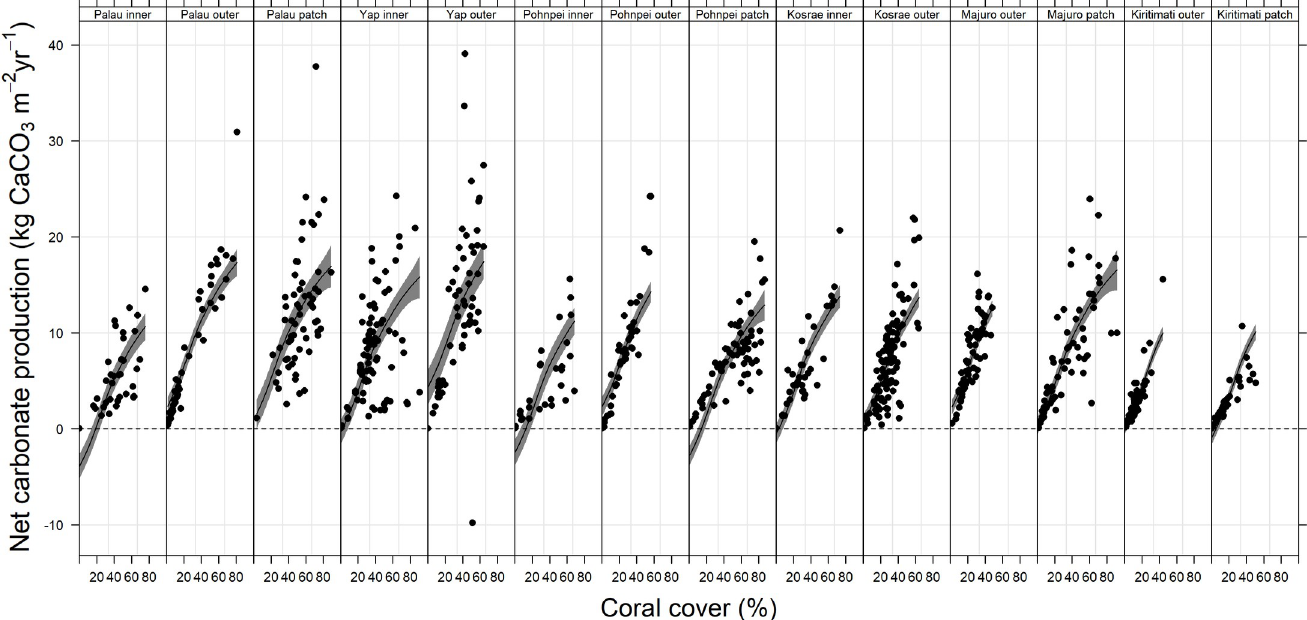
Fig 5. The relationship between the percentage (%) live coral cover and the net carbonate production rates (kg CaCO 3 m -2 yr -1 ) for each habitat (i.e., inner, patch, and outer reefs) at each of the six Pacific Ocean study locations [i.e., at Palau and Yap (2017), Pohnpei and Kosrae (2018), and Majuro and Kiritimati (2019)]. The lines are best-fit generalized additive models, and the polygons display the standard errors.